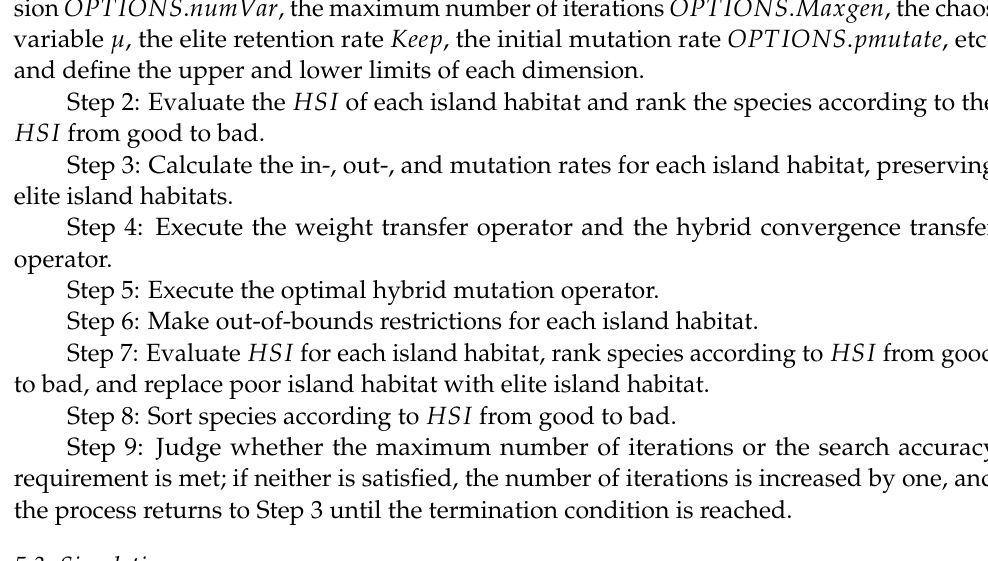
Figure 13. Fractional-order PID control system model.